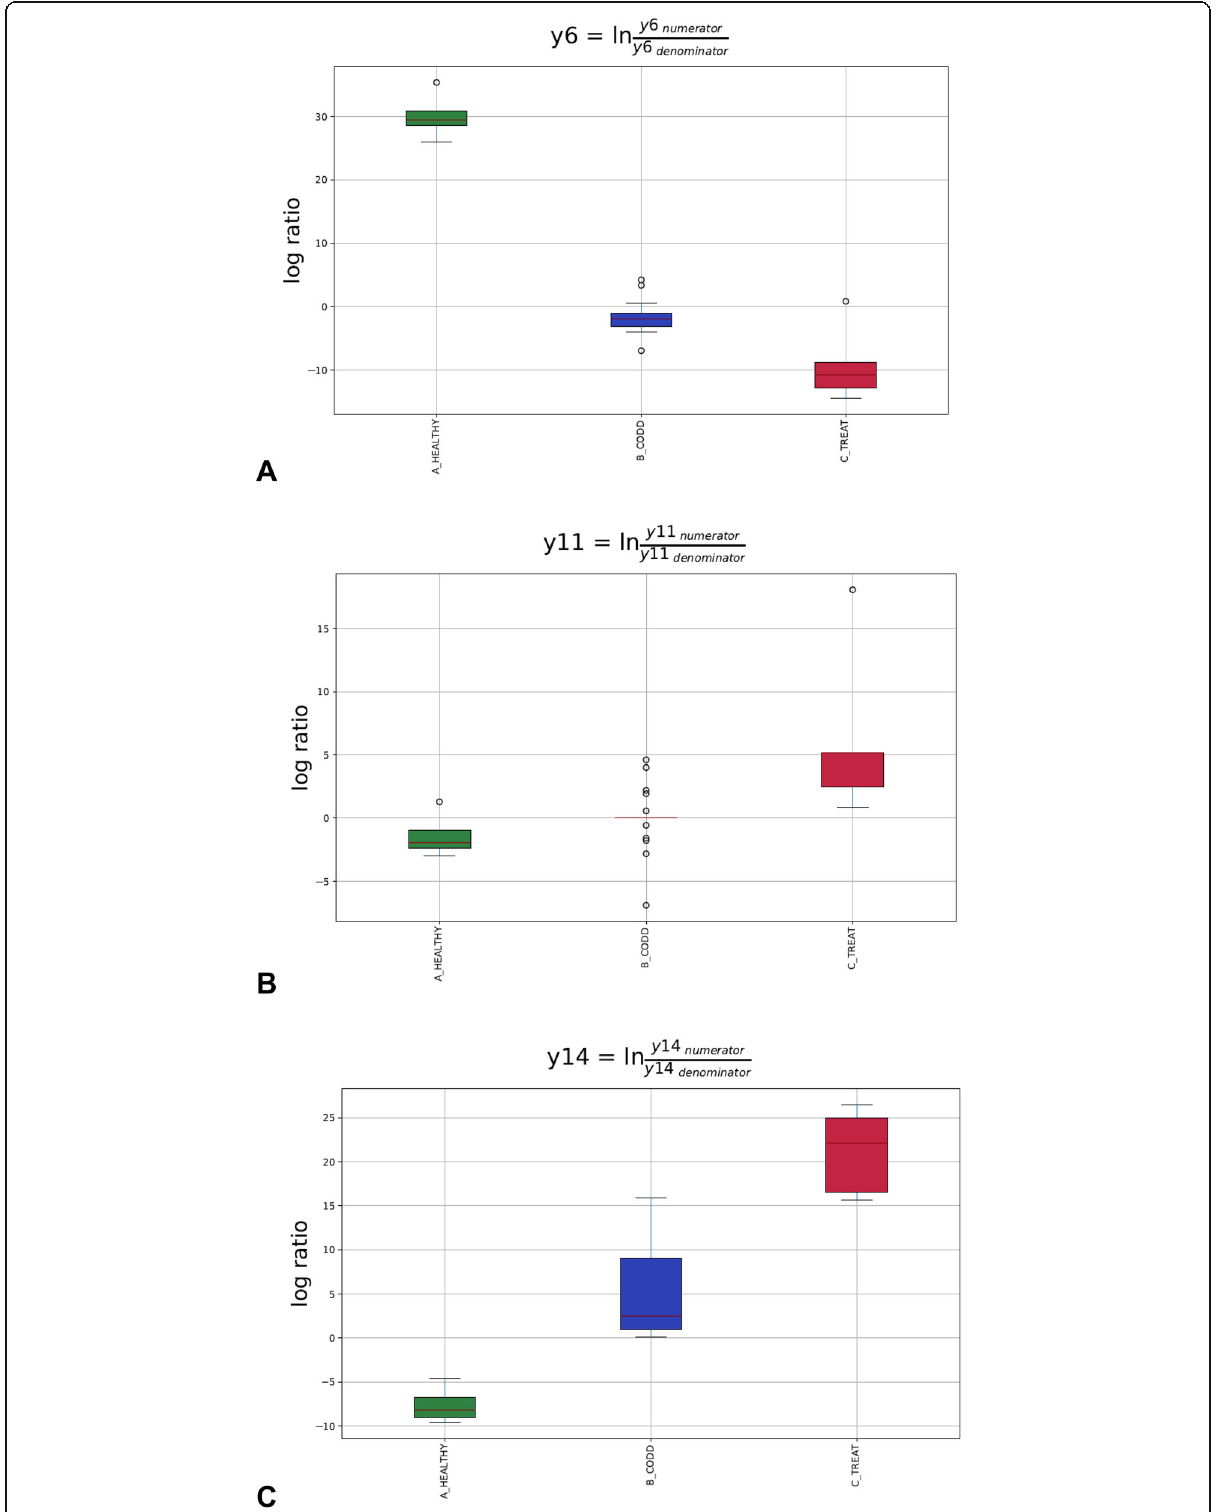
Fig. 10 Gneiss analysis Log 10 ratio balances whose log 10 ratio balance was significantly different ( p < 0.05) between microbiomes of samples taken from healthy (A_Healthy), CODD affected (B_CODD) and antibiotic treated (C_Treated) sheep ’ s feet. A lower log 10 ratio shows a shift in the balance toward denominator ASVs whilst a higher log 10 ratio shows a shift towards numerator ASVs as visually represented in Fig.